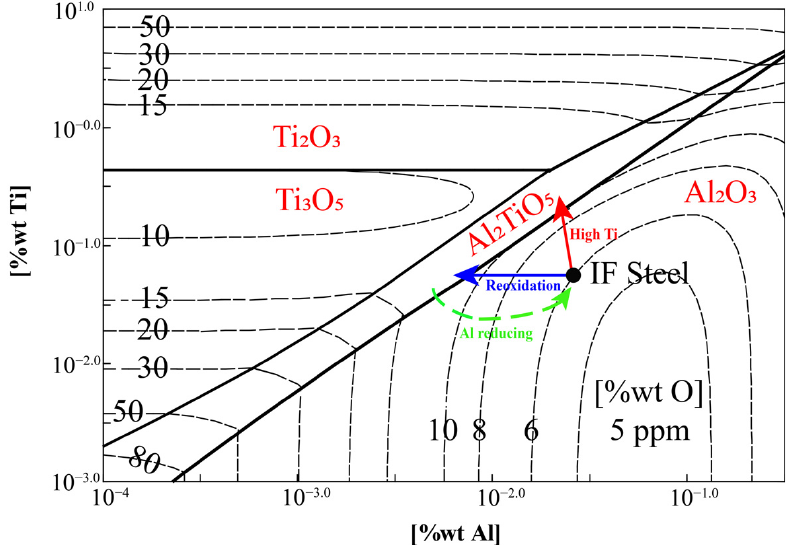
Figure 15. The equilibrium phase diagram for the Fe-Al-Ti-O system at 1873 K.